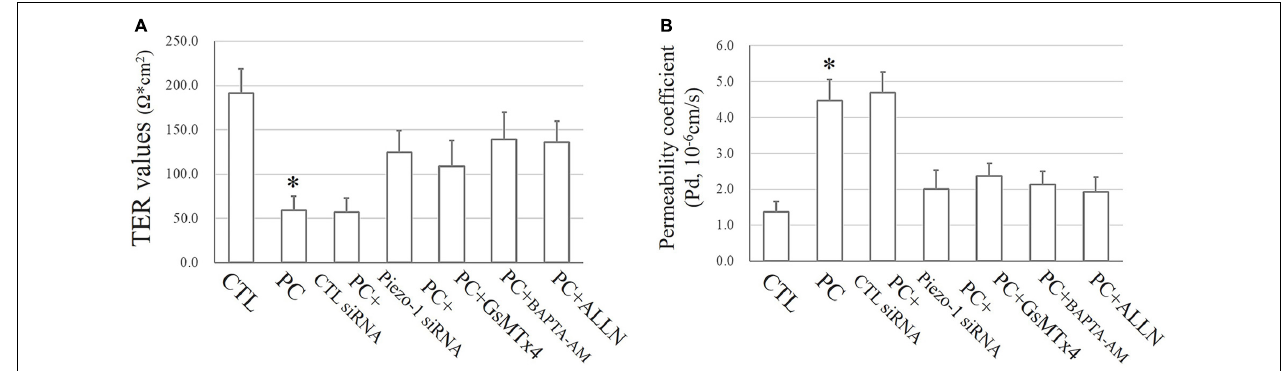
FIGURE 8 | Epithelial TJ function assessments. Cells propagating normal atmospheric pressure were set as controls (CTLs). HSAECs exposed to a 10 cmH 2 O pressure for 12 h were marked as the ‘pressure cultured (PC)’ group. Data are represented as the mean ± SD, n = 6. Differences between groups were analysed using one-way ANOVA, followed by Bonferroni’s test. (A) TER values of HSAECs. ∗ P < 0.05 vs. ‘PC + piezo-1 siRNA,’ ‘PC + GsMTx4,’ ‘PC + BAPTA-AM,’ and ‘PC + ALLN.’ (B) Paracellular permeability assay in HSAECs. The results are described as permeability coefficients (Pd 587 values). ∗ P < 0.05 vs. ‘PC + piezo-1 siRNA,’ ‘PC + GsMTx4,’ ‘PC + BAPTA-AM,’ or ‘PC + ALLN.’